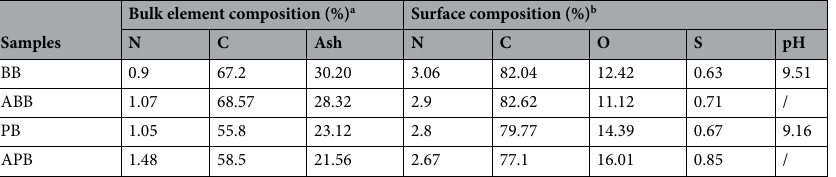
Table 1. Characterization of biochars. BB bush biochar, ABB aged bush biochar, PB peanut shell biochar, APB aged peanut shell biochar. a Data obtained using an elemental analyzer. b XPS measurement.